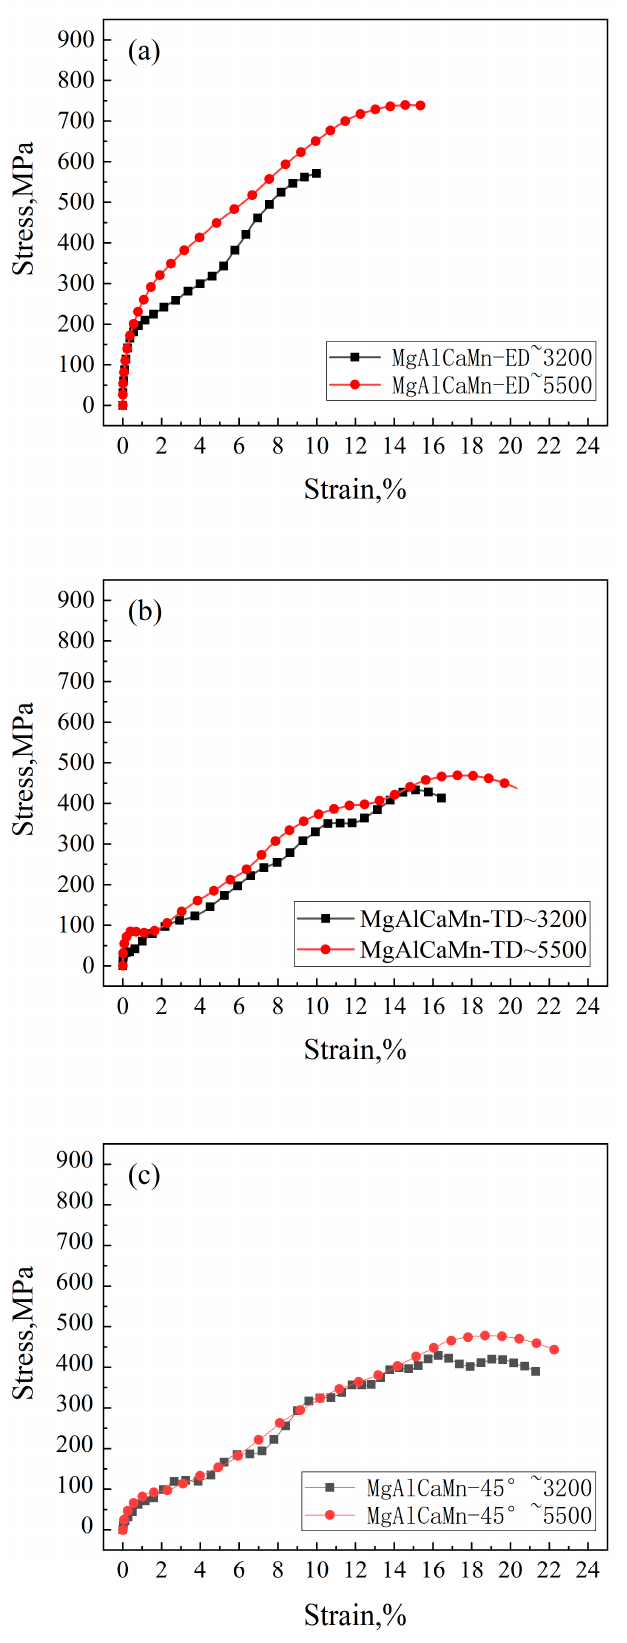
Figure 4. Stress–strain curves of Mg-Al-Ca-Mn alloy under high strain rate compression in the ( a ) extrusion direction (ED), ( b ) transverse direction (TD), and ( c ) Horizontal 45°.